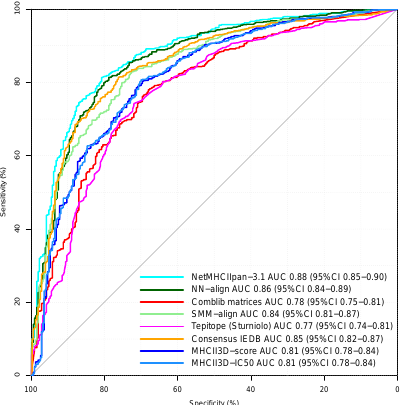
Figure 1. Classification performance of six existing prediction methods and our approach on a set of 1078 entries provided by Immune Epitope Database (IEDB) weekly benchmarks